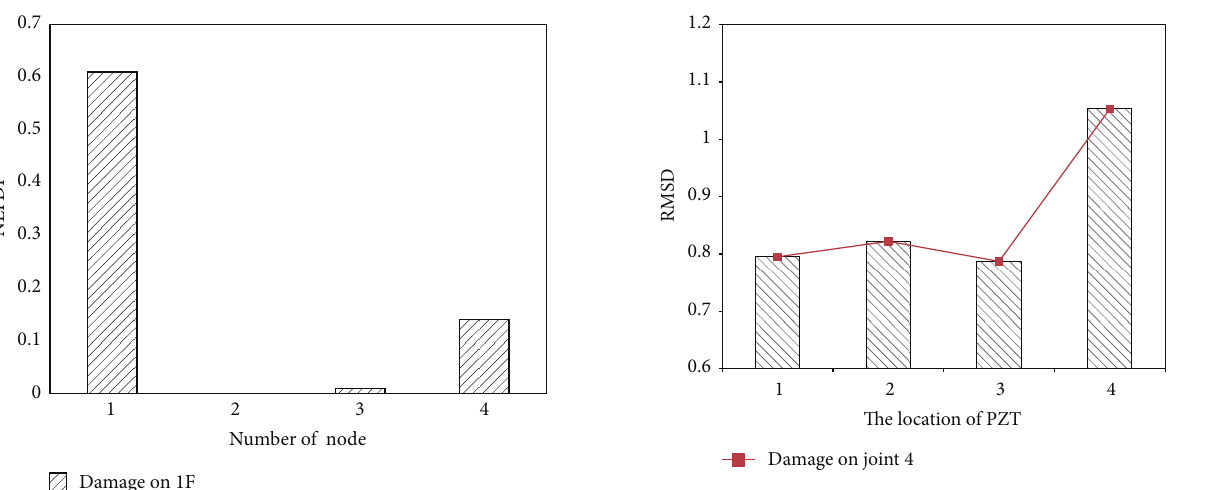
Figure 10: The NEFDI: damage on the 1st floor.